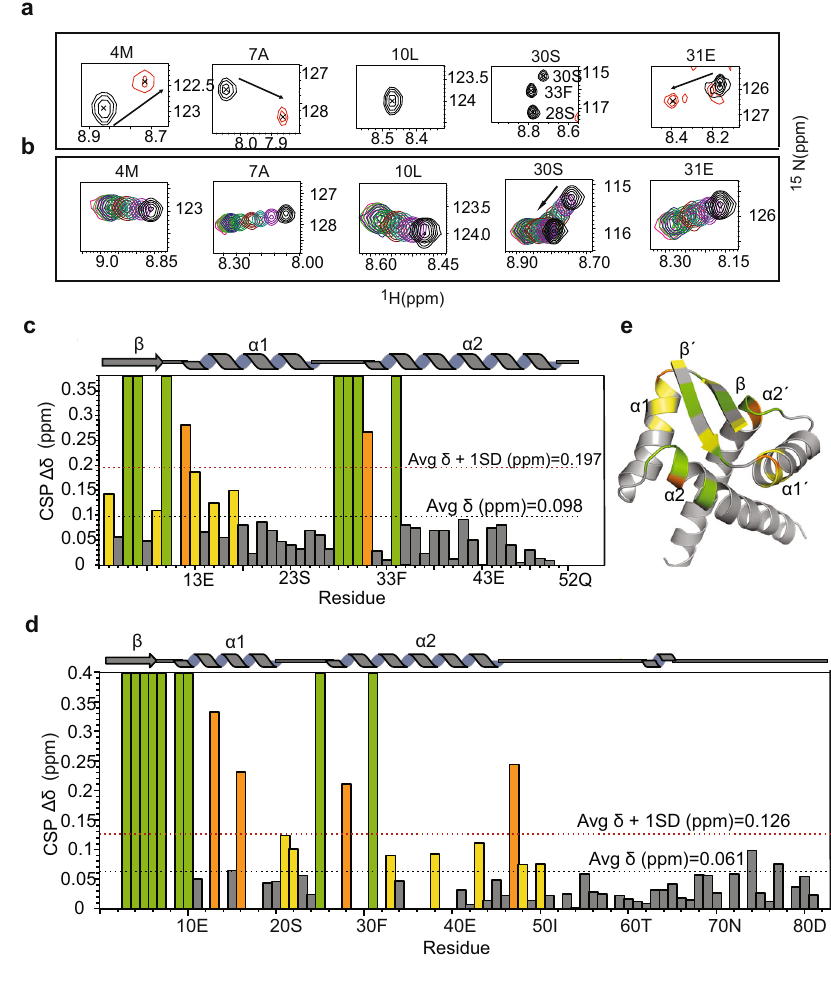
Fig. 5 Chemical Shift Perturbation (CSP) upon operator DNA binding. a Chemical shift perturbations observed for few residues in the 1 H- 15 N HSQC (Supplementary Fig. S8b) of nMazE6 upon titration with cognate operator DNA at a 1:2 (nMazE6:DNA) molar ratio. Spectra of free nMazE6 (Black) and nMazE6 in complex with operator DNA at a protein:DNA ratio of 1:2 (Red) are shown. Changes in chemical shifts of backbone amide resonance position between the fi rst and last titration points are indicated by black arrows. For CSP of MazE6, refer Fig. S8A. b Chemical shift perturbations of key residues observed in the 1 H- 15 N HSQC of nMazE6 upon titration with mazEF6 mutated operator DNA. For full spectrum, refer Supplementary Fig. S9b. c Plot of cumulative CSP as a function of the primary structure of nMazE6. d Plot of cumulative CSP as a function of the primary structure of MazE6. Average CSP and average CSP plus one standard deviation are indicated by dotted lines (Black) and (Red), respectively. e Residues that showed above-average CSP (yellow), above-average CSP + 1SD (orange), and residues that completely broadened and hence disappeared upon DNA binding (green) are mapped on the structure of nMazE6. Source data are provided in the Supplementary Data 1.